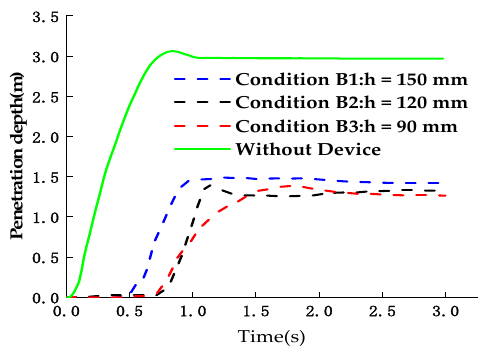
Figure 21. Bow impact depth time-history curve.